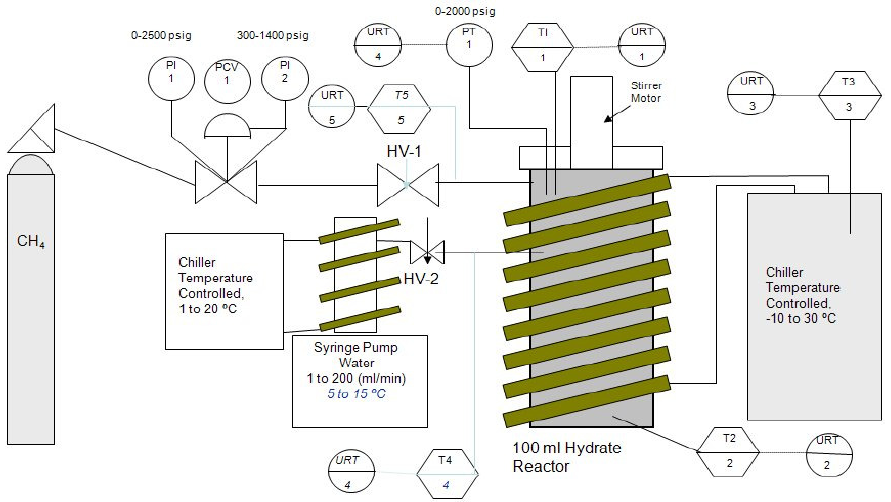
Figure 3. Drawing of NETL 100 mL gas hydrate unit utilized for the initial rapid gas hydrate formation